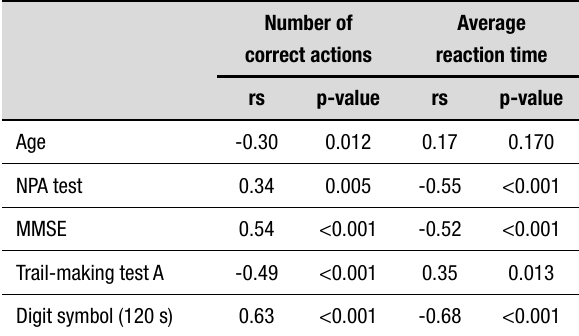
Table 2. Relationships between the lower extremity reaction test and other tests.